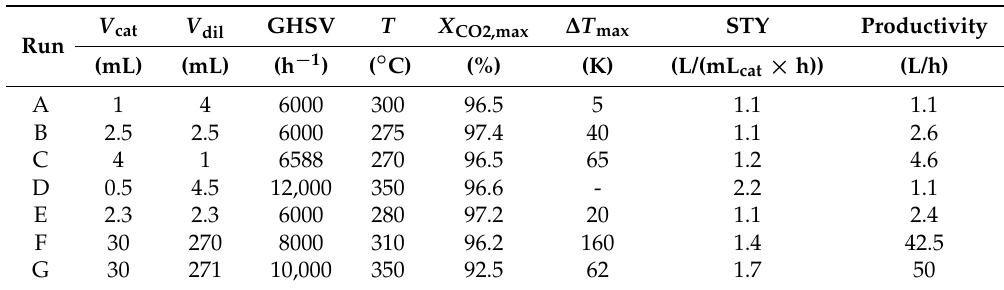
Table 5. Comparison of reactor configurations at the temperature set points with highest